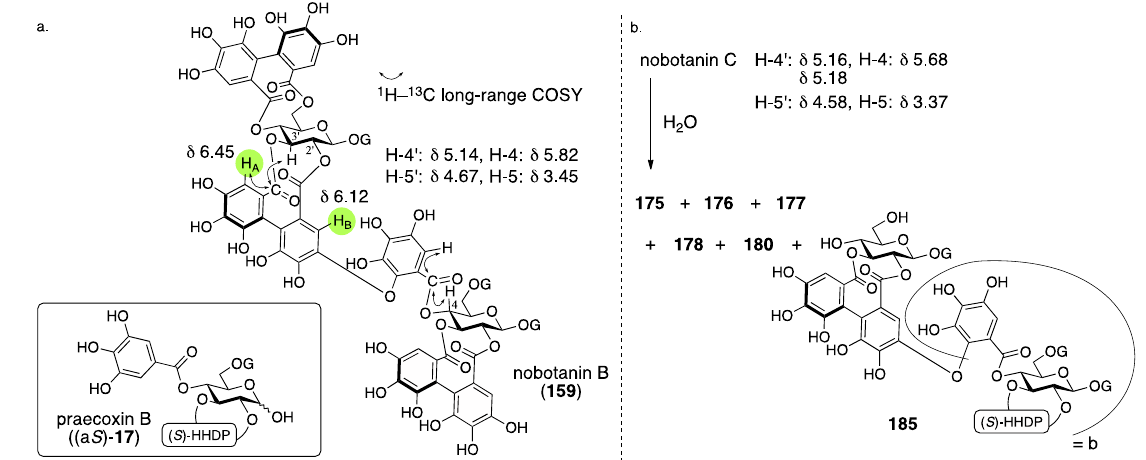
Figure 58. The data used for the revision to the latest structures of nobotanins B, C, and E ( 159 , 161 , and 163 , respectively).